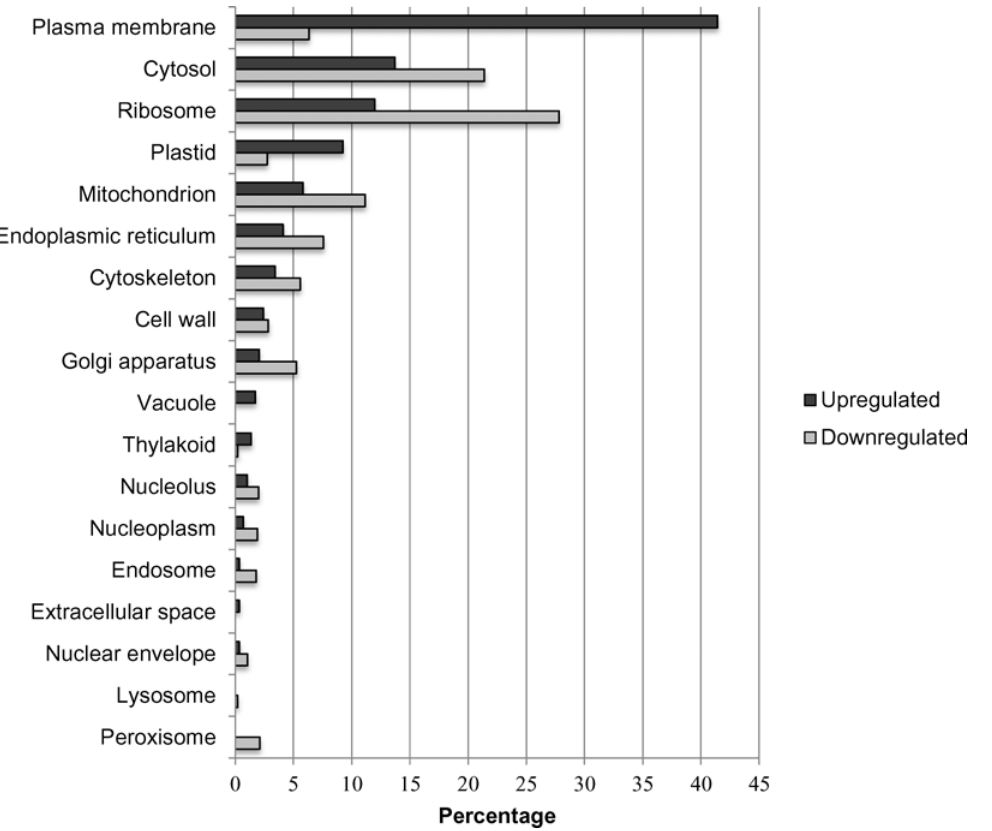
Fig 13. Percentage of upregulated (total number = 292) and downregulated (total number = 949) transcripts when nickel resistant Betula papyrifera genotypes were compared to nickel susceptible genotypes. Transcripts were assigned gene ontology and grouped by cellular compartment using